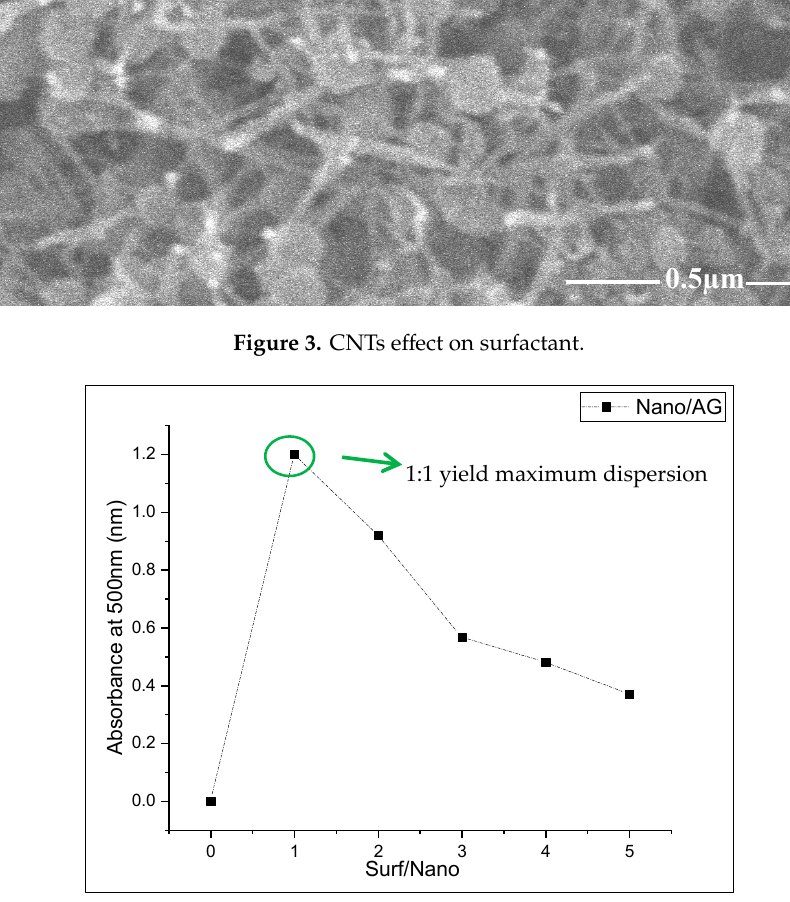
Figure 4. Absorbance of nanocomposite using AG as a surfactant.